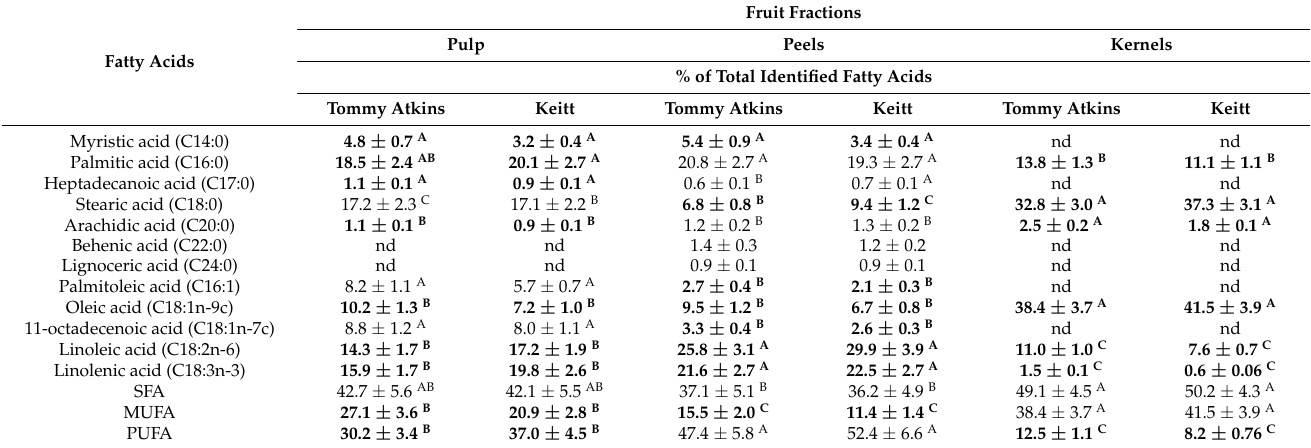
Table 6. Fatty acids composition of three fruit fractions of mango fruit (pulp, peels and